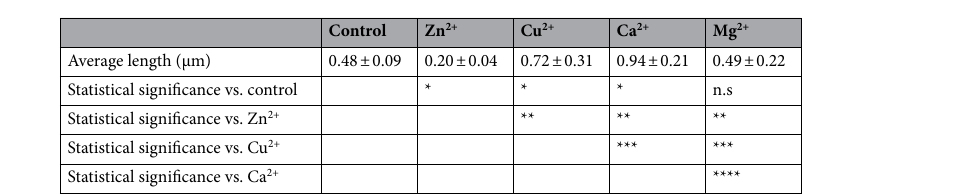
Table 2. Average lengths of α-Syn fibrils formed in presence and absence of cations. The lengths were determined via analyzing AFM images using Nova software (version 1.26.0.1443). * p < 0.05 significant difference compared to the control group. ** p < 0.05 significant difference compared to the Zn 2+ group. *** p < 0.05 significant difference compared to the Cu 2+ group. **** p < 0.05 significant difference compared to the Ca 2+